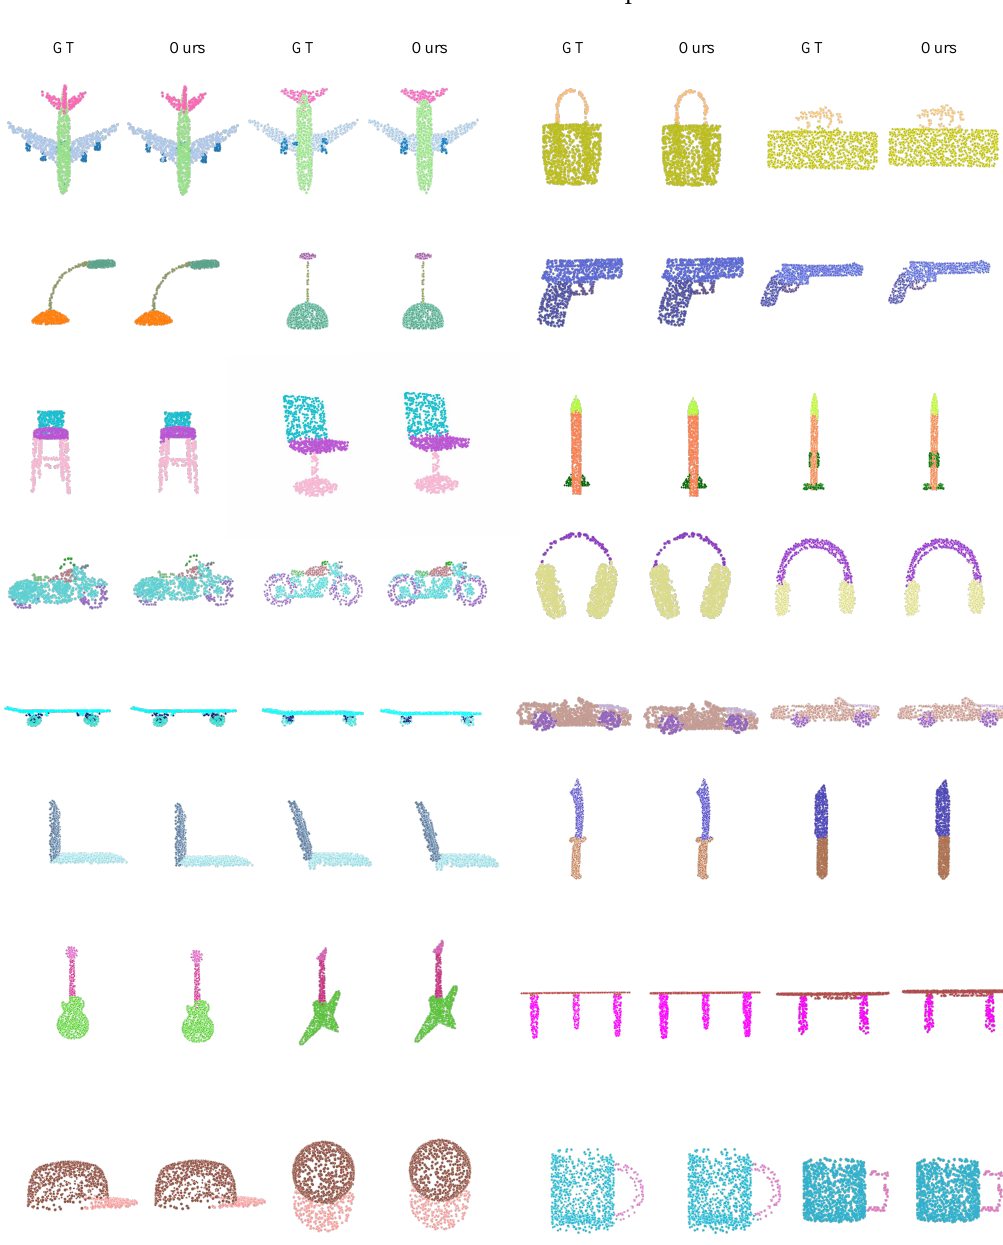
Figure 3. Visualization of part